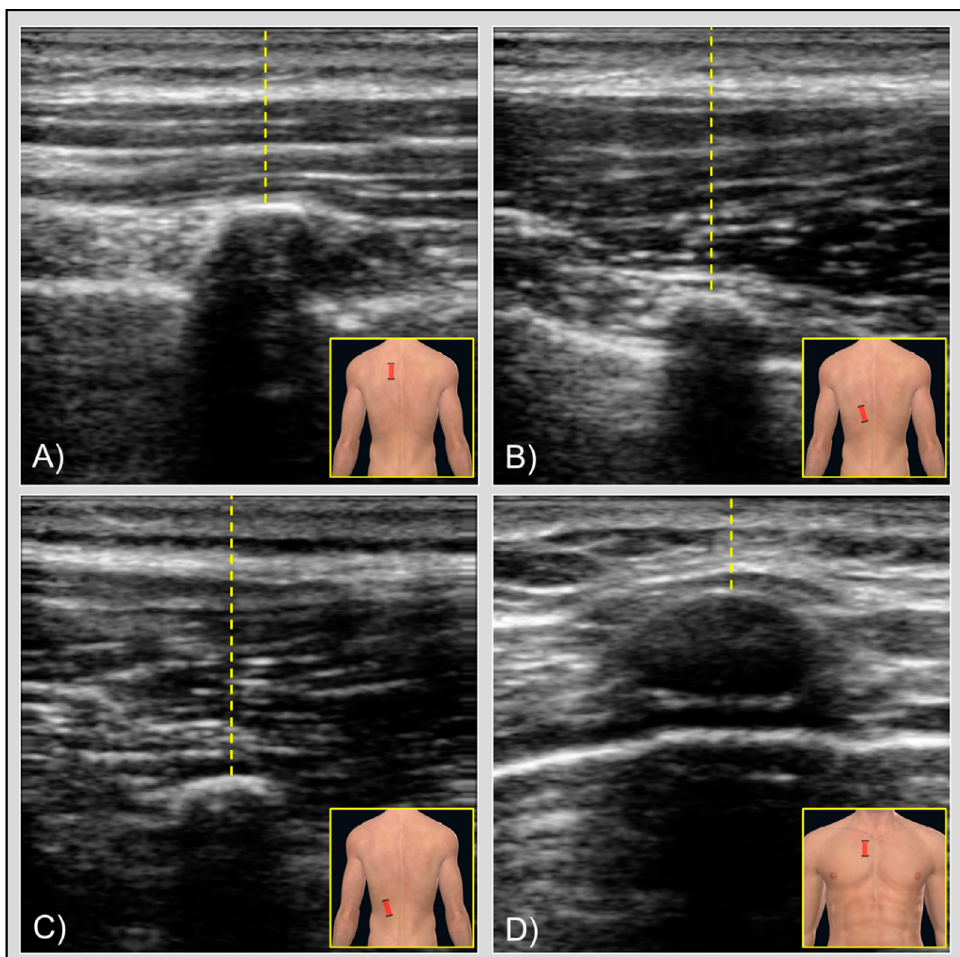
Figure 1. Figures showing the transducer placement (brackets) with ultrasound images and skin-to-rib measurement (yellow lines) for ( A ) rhomboid muscle, ( B ) lower trapezius muscle, ( C ) iliocostalis muscle, and ( D ) pectoralis major muscle. At the center of each image, the curved hyperechoic area represents the apex of the rib. Below the bone is visible the typical hypoechoic signal, also known as acoustic shadowing. Slightly deeper, in quadrants ( A , B , D ), you can also notice other hyperechoic tissues lateral to the bone, which represent the pleura. In the rhomboid muscle image ( A ), the di ff erent muscle layers are also visible: directly above the skin the middle trapezius muscle, just below it the rhomboid muscle, and around the rib the intercostal muscles. In the pectoralis major muscle image ( D ), the rib apex is less visible than in the other images due to the costal cartilages.